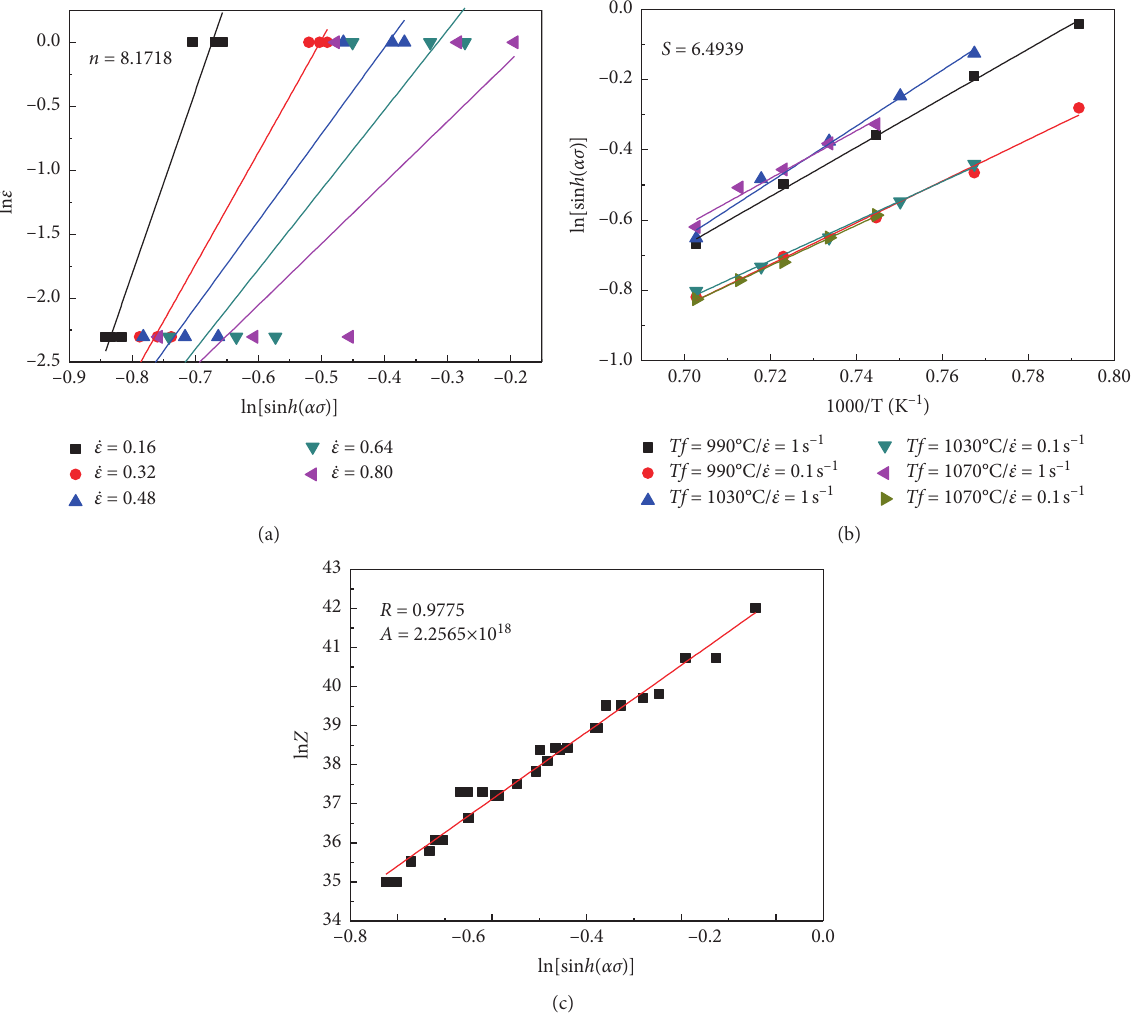
Figure 4: Correlations between (a) ln _ ε − ln [ sin h ( ασ )] , (b) ln [ sin h ( ασ )]− ( 1/ T ) , and (c) ln Z − ln [ sin h ( ασ )] during nonisothermal multipass